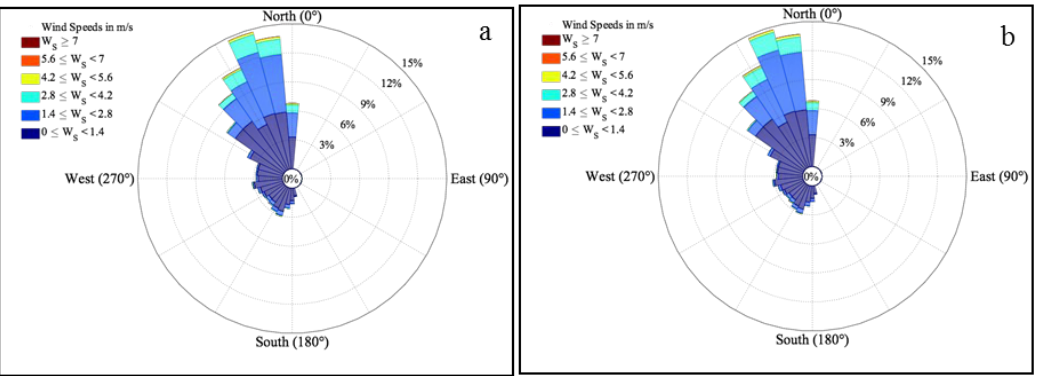
Figure 10. Wind ( a ) and drifter ( b ) “roses” for the period of drifter deployment during the closed state (E2) on 9 September 2015. To more easily match the drift directions, the wind roses are shown with the directions that the winds were blowing. Both wind and drifter speeds are given in m s − 1 .